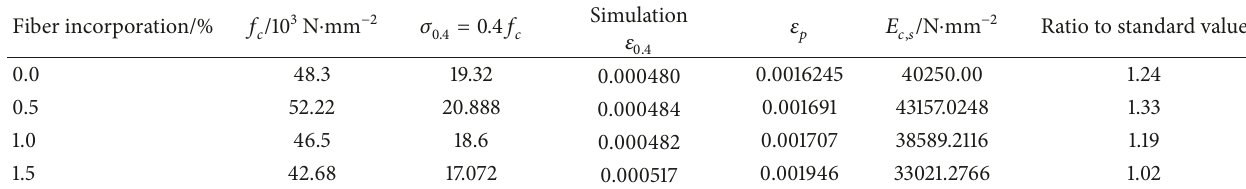
Table 6: Secant modulus of fiber reinforced concrete.